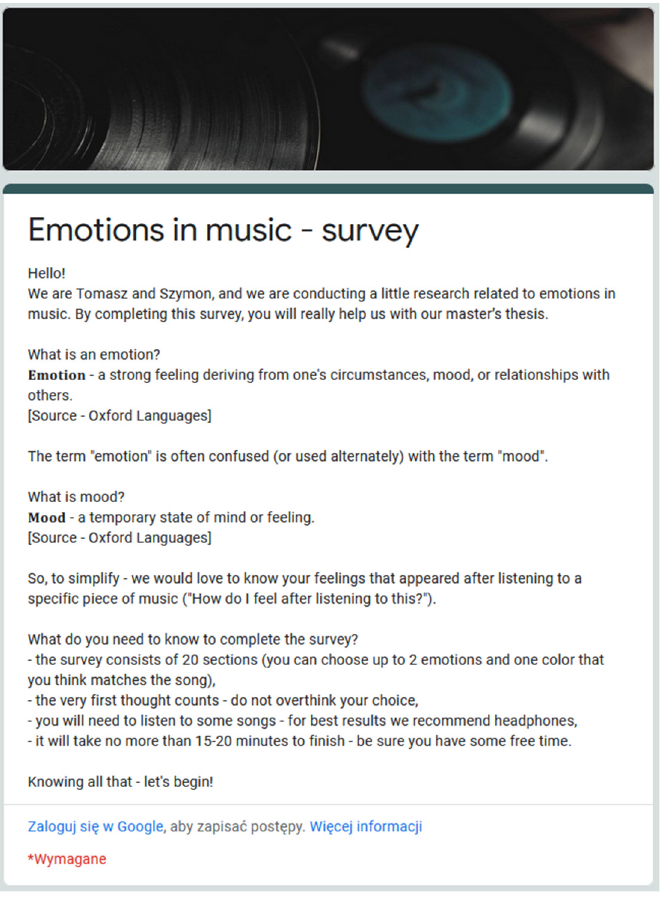
Figure 4. Introduction page of the constructed web survey (description in Polish says: Sign in with Google to save your progress).